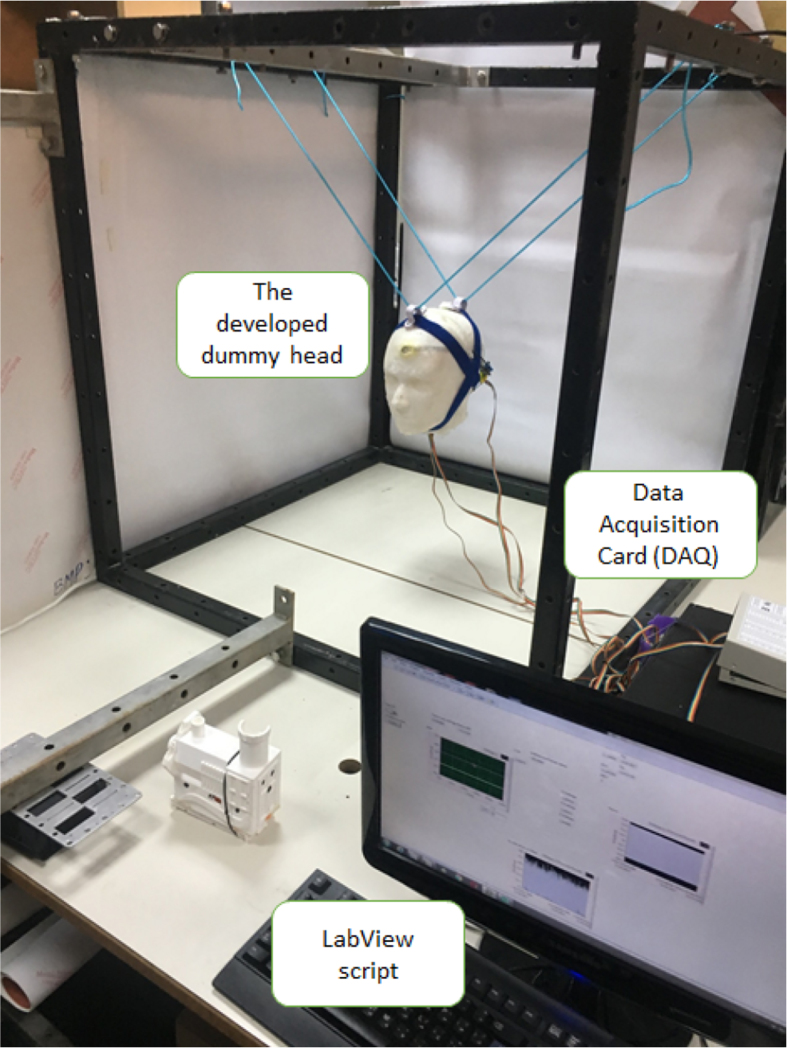
The experimental setup [2].